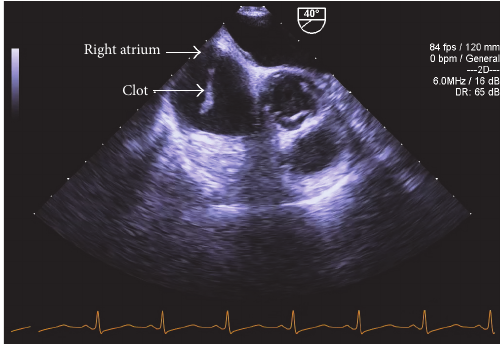
Figure 4: Preanhepatic phase. Modified TEE midesophageal right verticular inflow-outflow view: serpiginous clot in the right atrium.